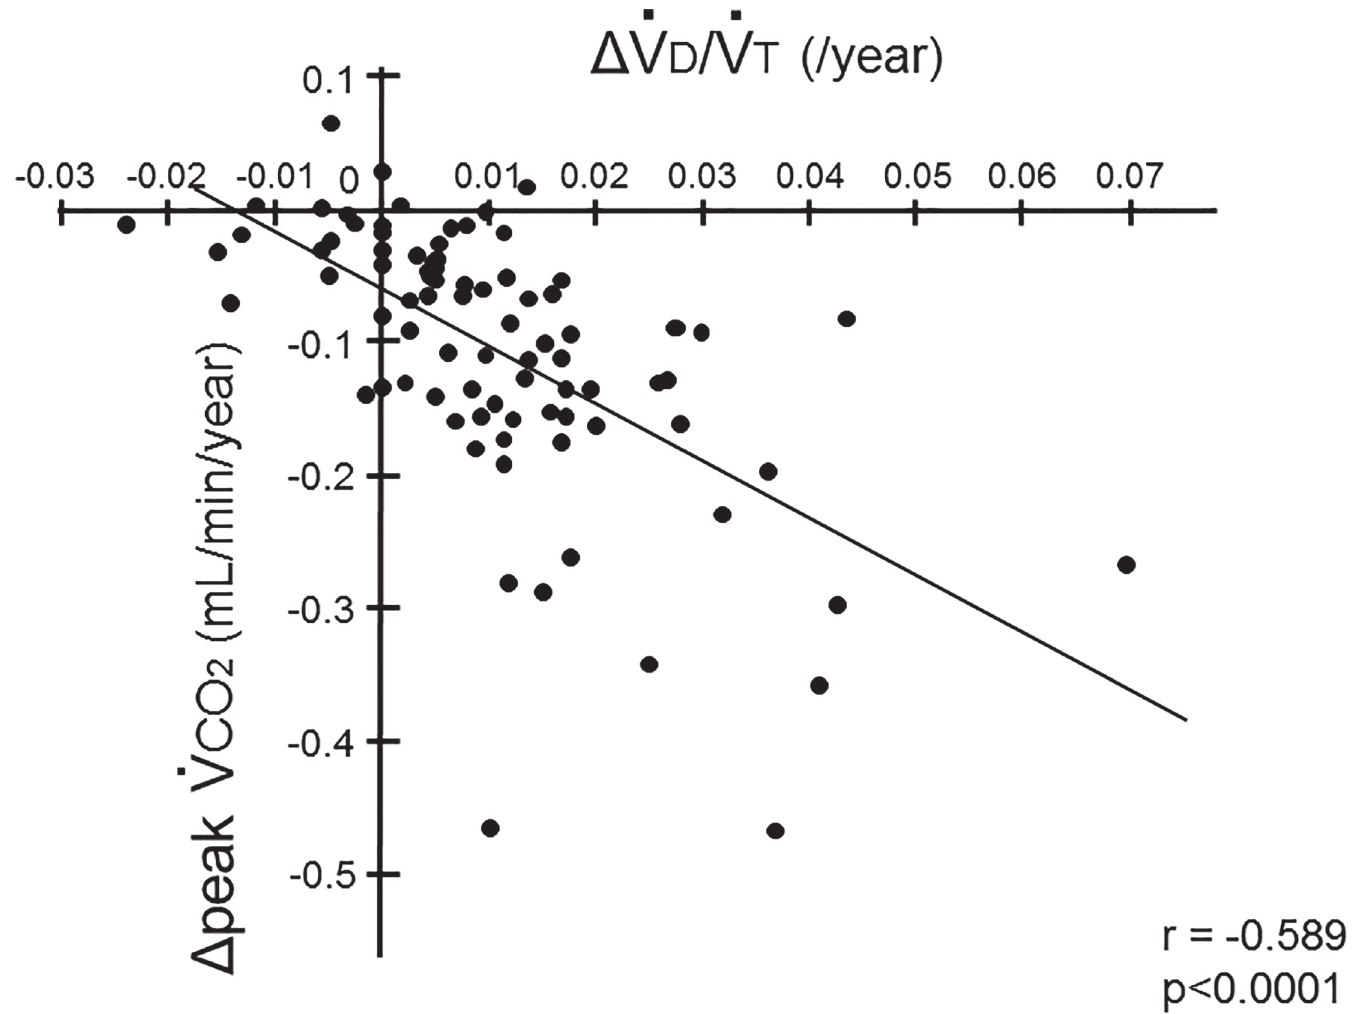
Fig 8. Association between the decline in CO2 production and the increase in dead space. The mean annual changes in peak _ V CO 2 ( Δ p _ V CO 2 ) were significantly correlated with those in the dead space fractions ( Δ _ V D / _ V T ) (p < 0.0001, r =